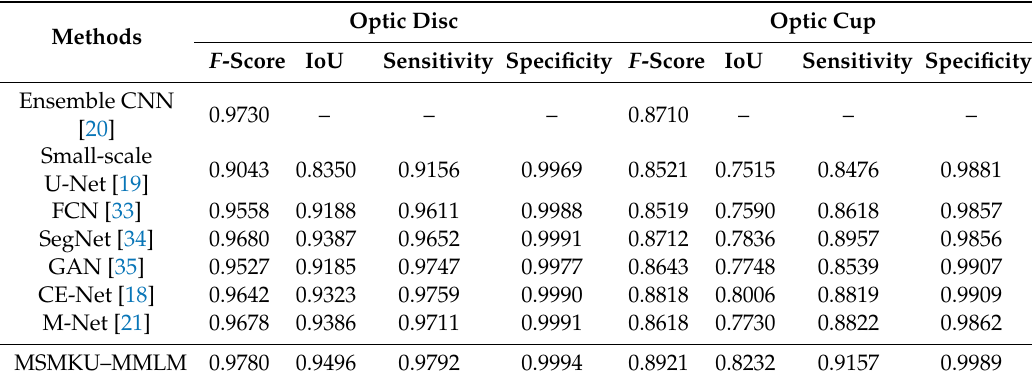
Table3. ComparisonswithdeeplearningmethodsforODandOCsegmentationonDRISHTI-GSdataset.